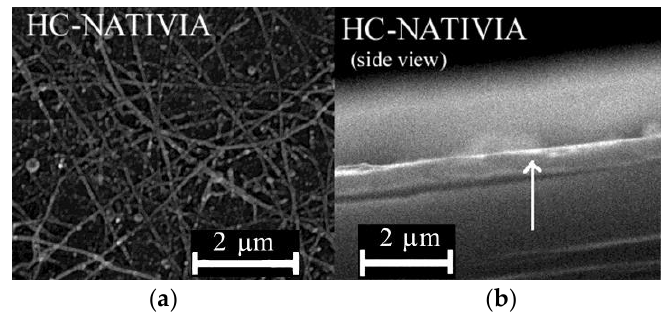
Figure 6. Scanning electron microscopy (SEM) images of the HC-NATIVIA sample: ( a ) Morphology of the coated surface; and ( b ) side view showing the coated layer.